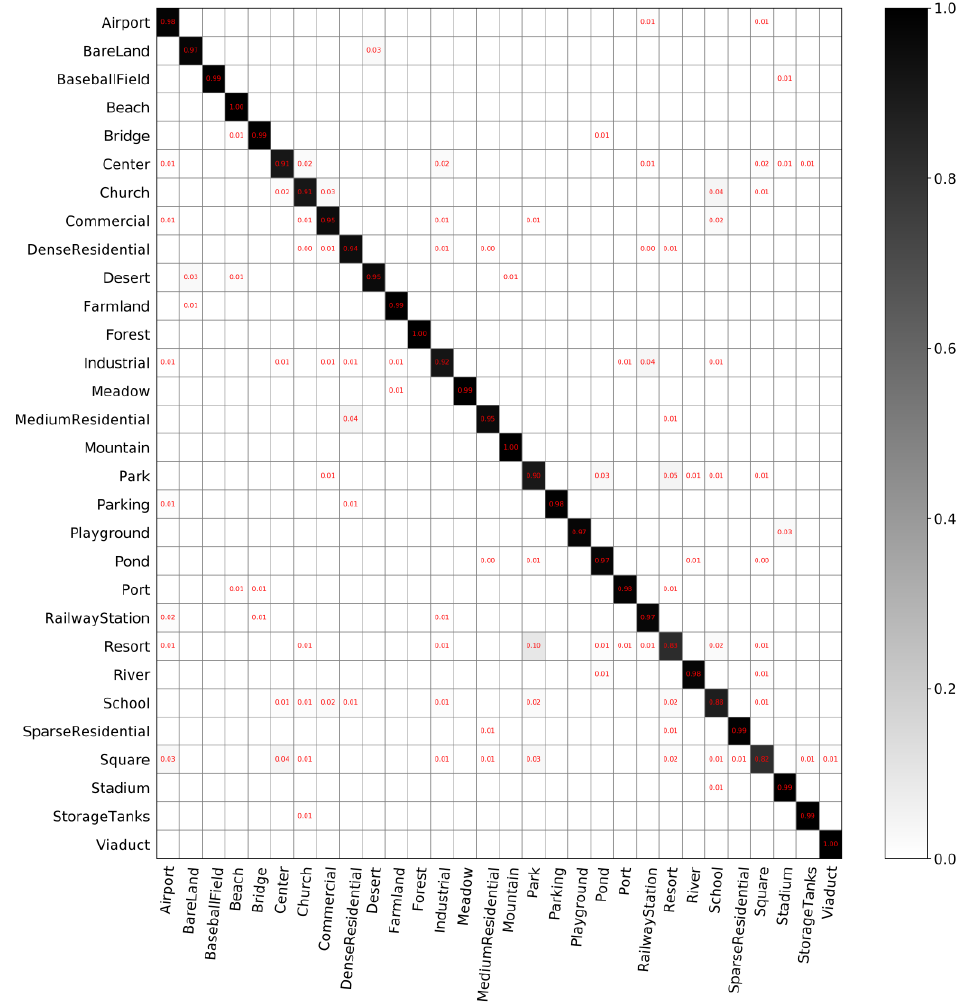
Figure 6. Confusion matrix on AID with training set of 25% and validation set of 25%.